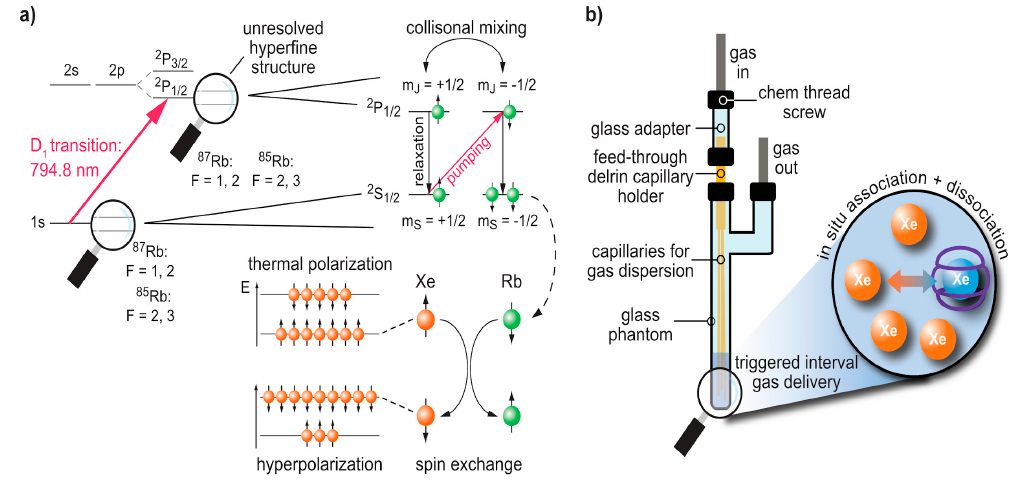
Figure 1. Production of hyperpolarized 129 Xe and reversible in situ association with a host. ( a ) The SEOP process constantly maintains a high polarization of the Rb electron spin system through selective pumping of the D 1 transition. This yields an overpopulation of one of the two spin states in the 2 S 1 / 2 ground state. Such polarized Rb serves as the source to polarize Xe by spin exchange, e.g., through a binary collision. The 129 Xe spin system is eventually converted from thermal polarization to a strong overpopulation far outside the thermal equilibrium. ( b ) Xe delivery into a sample solution and reversible binding to a